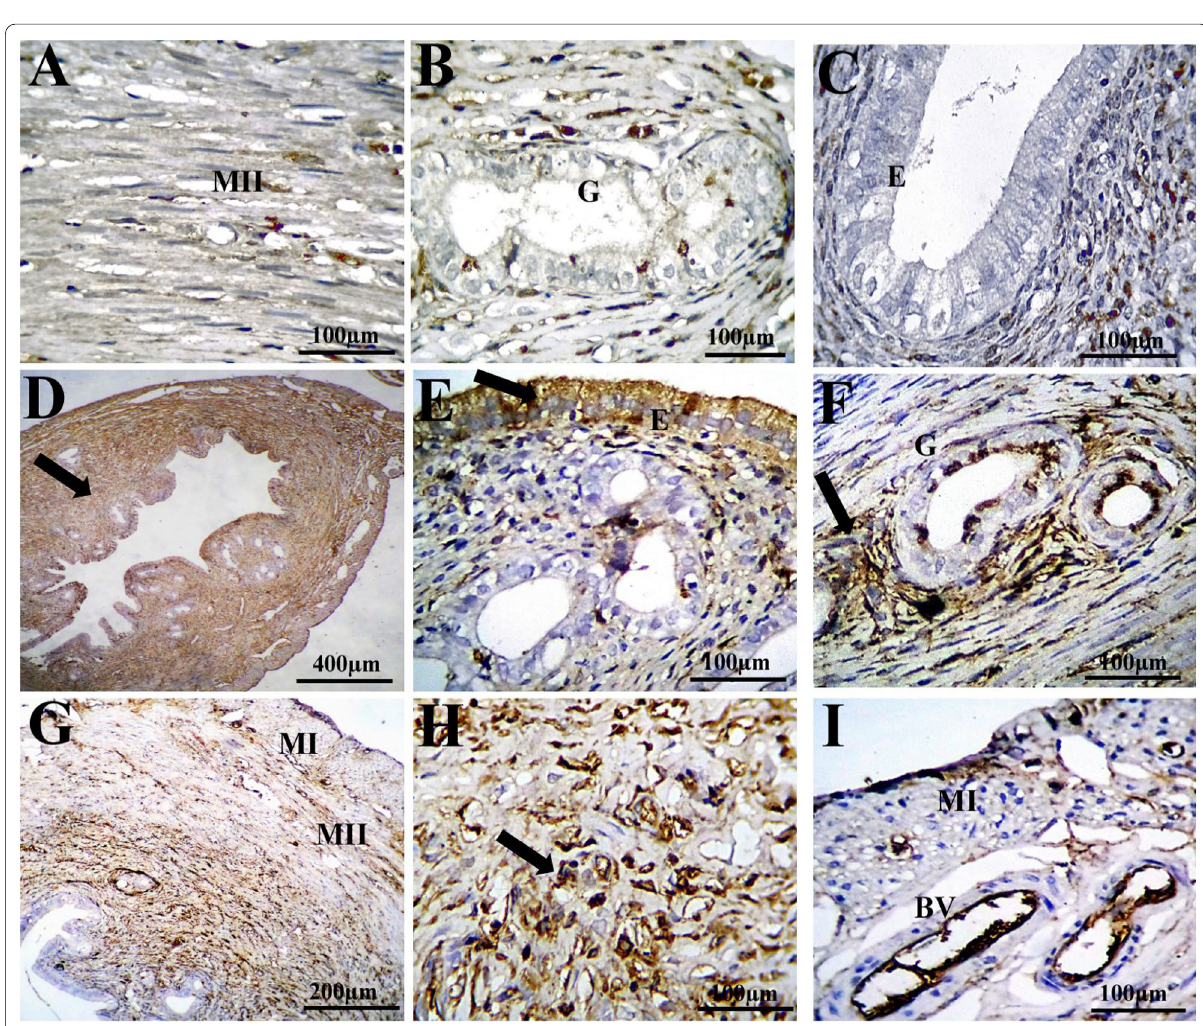
Fig. 6 Immunohistochemistry comparing caspase‑3 staining in uterine tissue ( n immune stain caspase‑3 was observed. Magnetite‑treated groups ( D – I ): positive expressions of immune stain caspase‑3 were observed (black